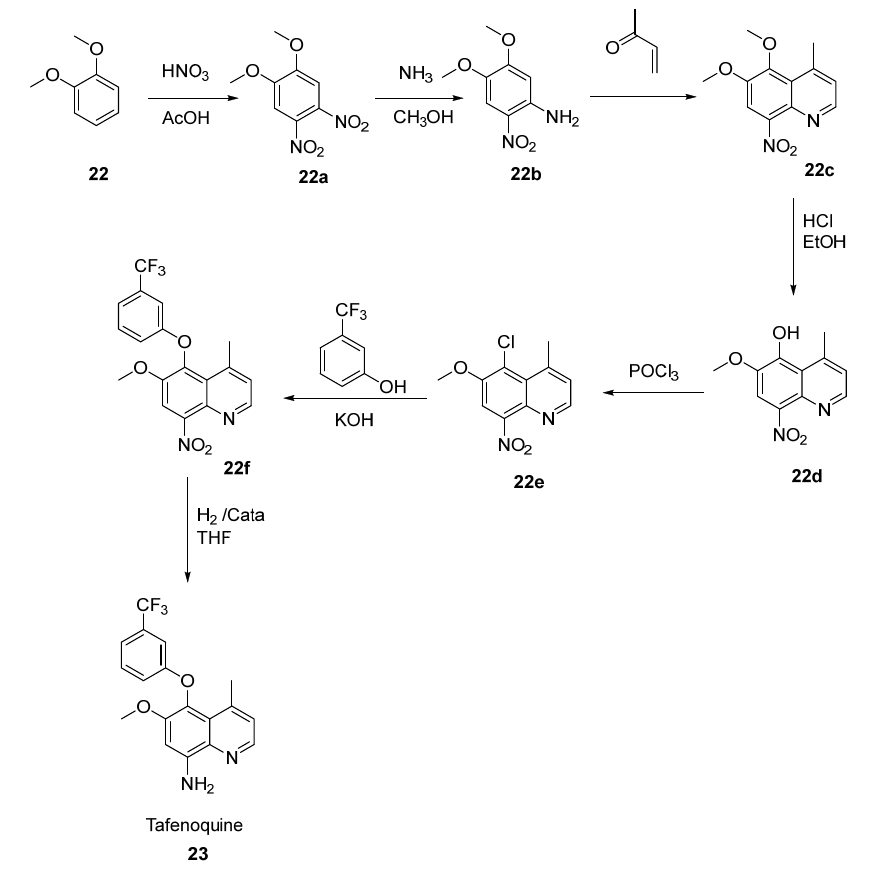
Figure 12. Synthesis and structure of tafenoquine.